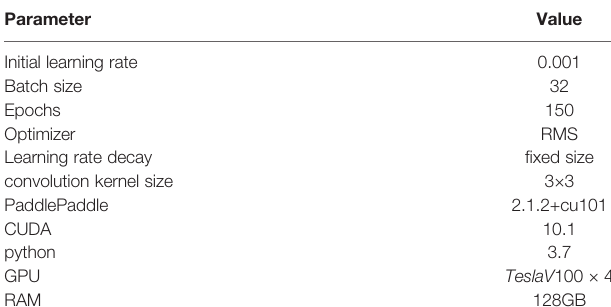
TABLE 1 | Hyperparameters and device parameters.